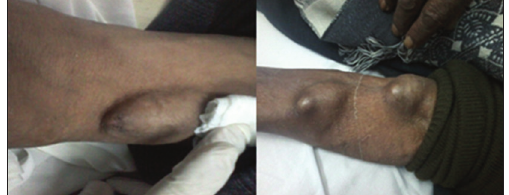
FIGURE 4. Aneurysm in